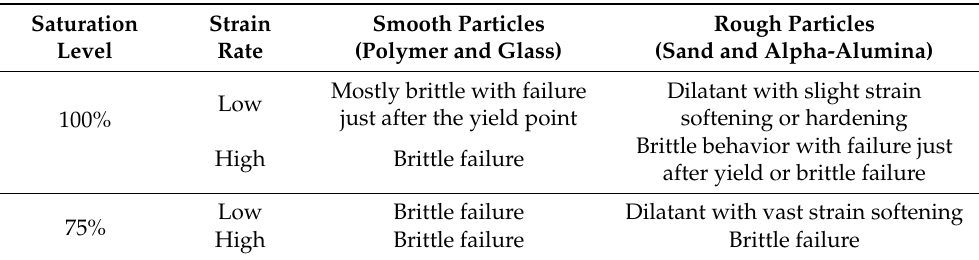
Table 2. Mechanical behavior overview concerning saturation levels, temperatures, strain rates, and particle properties. Saturation Strain Smooth Particles Rough Particles Level Rate (Polymer and Glass) (Sand and Alpha-Alumina) Mostly brittle with failure Dilatant with slight strain Low just after the yield point softening or hardening 100% Brittle behavior with failure just High Brittle failure after yield or brittle failure Low Brittle failure Dilatant with vast strain softening 75% High Brittle failure Brittle failure Particle surface properties and strain rate can influence mechanical behavior.